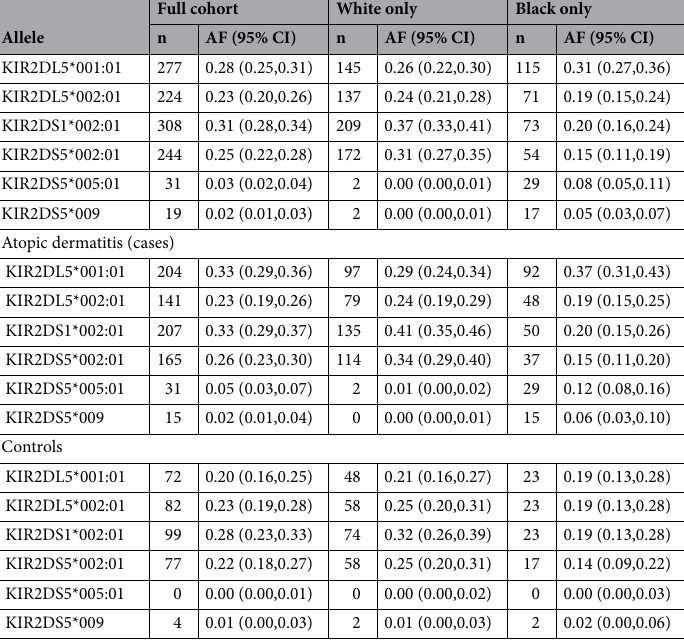
Table 1. Allelic frequencies ≥ 0.05 for 2DL5, 2DS1, and 2DS5. Allelic frequencies (AF) are presented with 95% CI for the full cohort or by race. n = sample